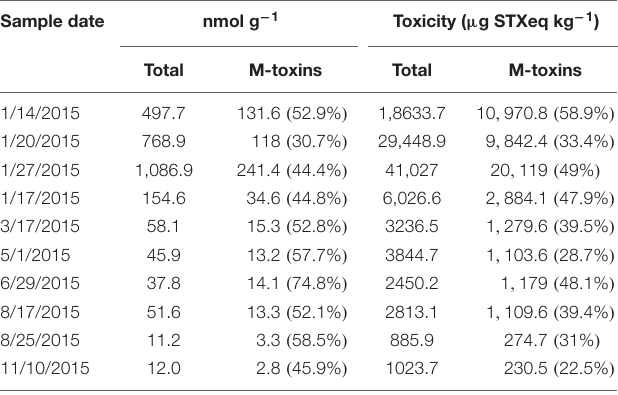
TABLE 2 | Contribution of M-toxins to molar concentration (nmol g − 1 ) of PST and total toxicity ( µ g STXeq kg − 1 ) calculated by HILIC-MS/MS analysis in geoduck visceral mass